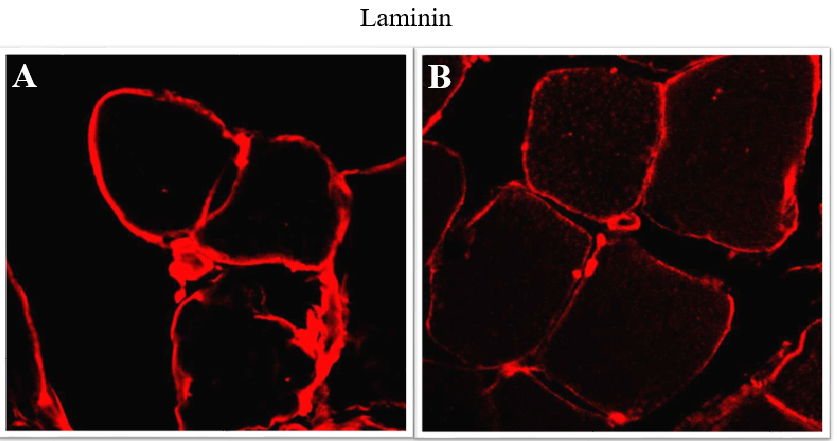
Figure 1. Immunofluorescence reactions anti Laminin (red fluorescence) in contralateral ( A ) and ipsilateral ( B ) masseter muscle of patients affected by unilateral posterior crossbite. The fluorescence pattern of laminin is mainly located around the muscle fibres, at basal lamina level. The contralateral muscle seems to show a higher Laminin staining pattern if compared to the ipsilateral. p -value < 0.05.